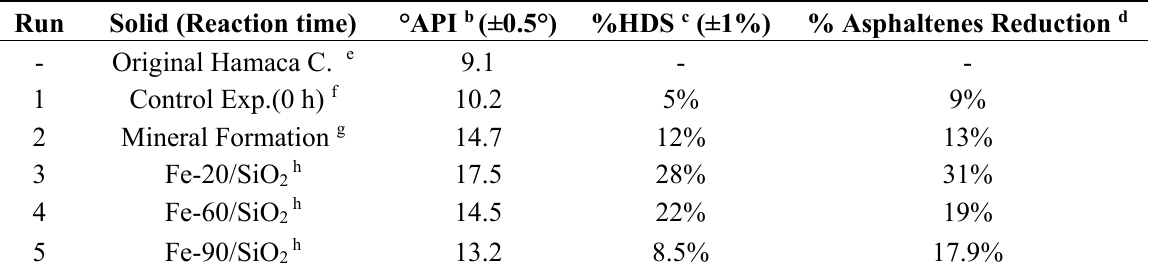
Table 1. Properties of the upgraded crude oil using tetralin under steam injection conditions a . Effect of the presence of iron